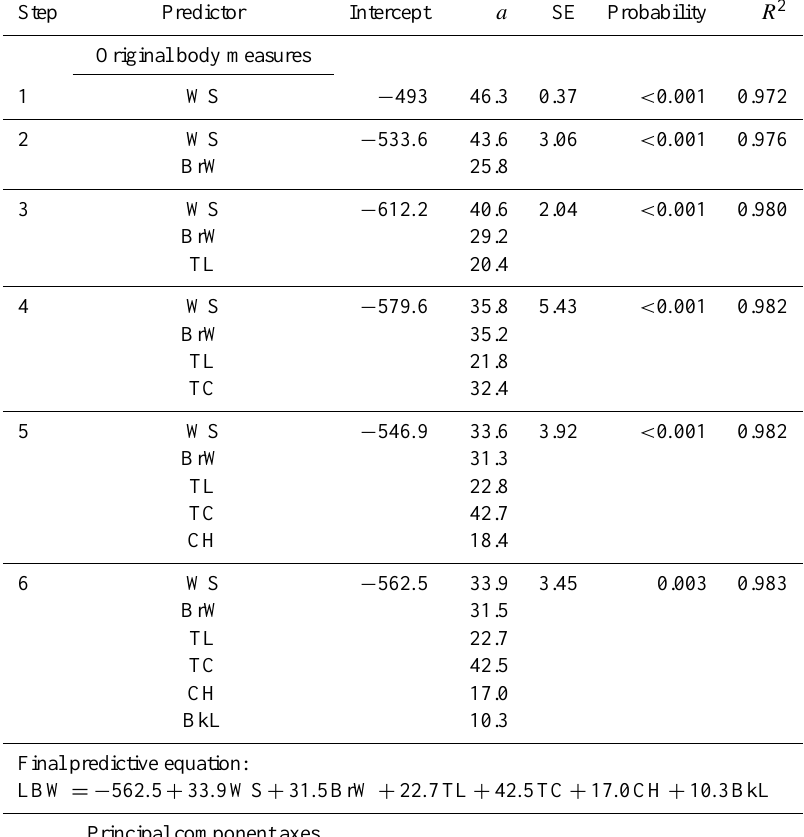
Table 8. Final stepwise equations for prediction of body weight for females. Step Predictor Intercept